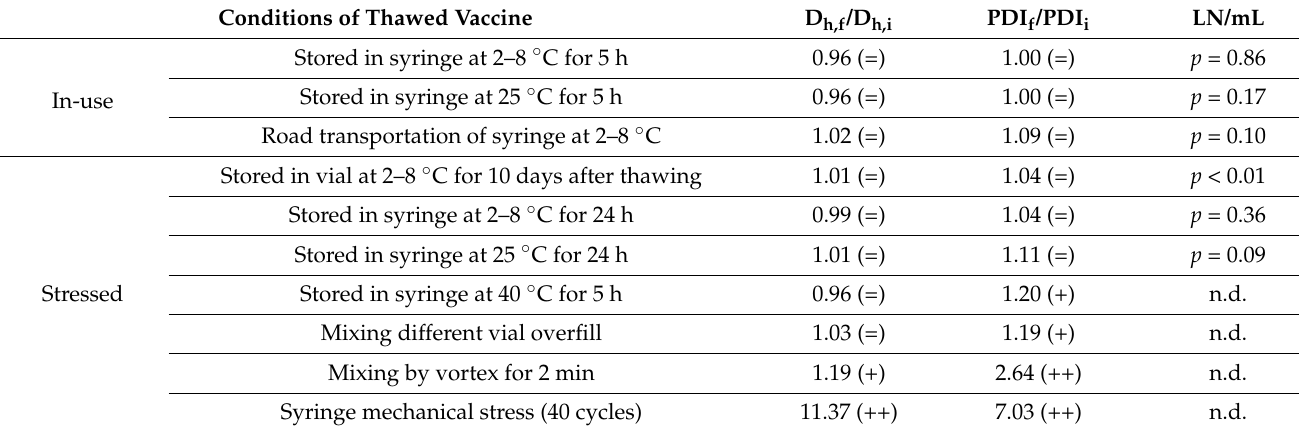
Table 2. Impact of storage and mechanical stress on the particle size distribution of LN expressed as the ratio of hydrody- namic diameter (D h ), which is calculated based on the main peak of DLS data, and polydispersity index (PDI) before and after the applied experimental condition. DLS: Legend of symbols expressing a variation <10% (=); 10–25% (+); >25% (++); NTA: p -values of Student’s T -test of particles before and after the applied experimental condition. n.d.: not determined. Conditions of Thawed Vaccine